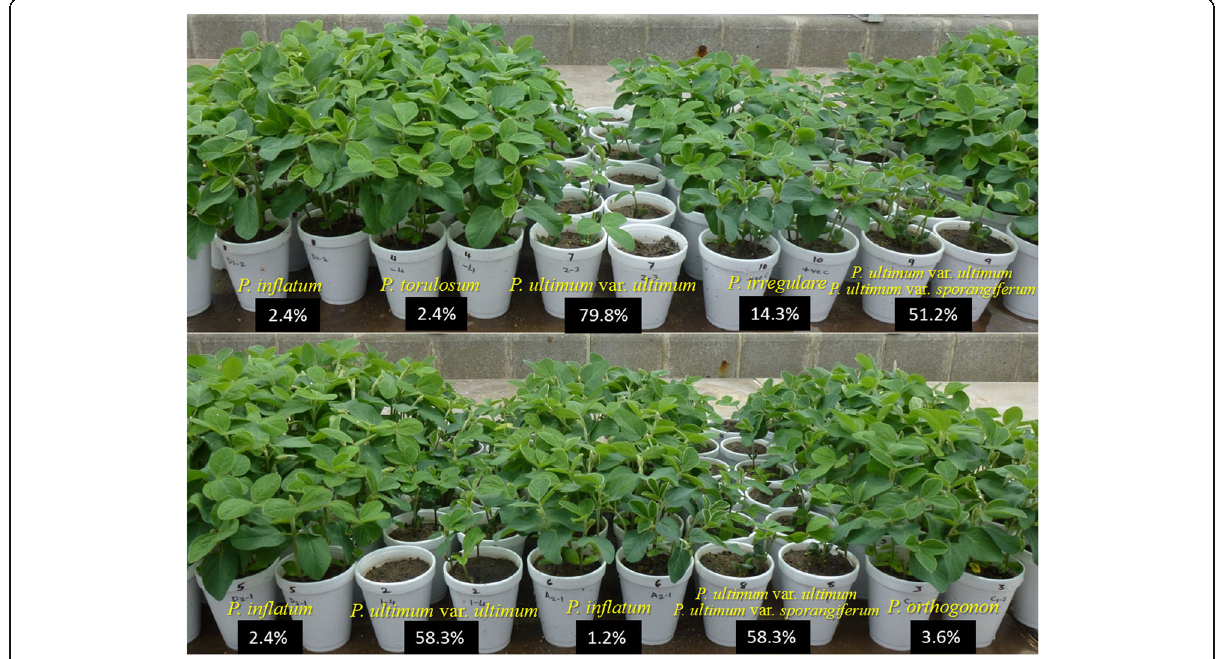
Fig. 4 Pathogenicity test results of Pythium spp. in greenhouse. Soybean seeds (cultivar: Pioneer 22T61RR) were planted in white foam cup (237mL) containing potting mixture mixed with individual Pythium isolates fermented on sterilized millet grains. Each isolate was tested in 12 cups and each cup with seven